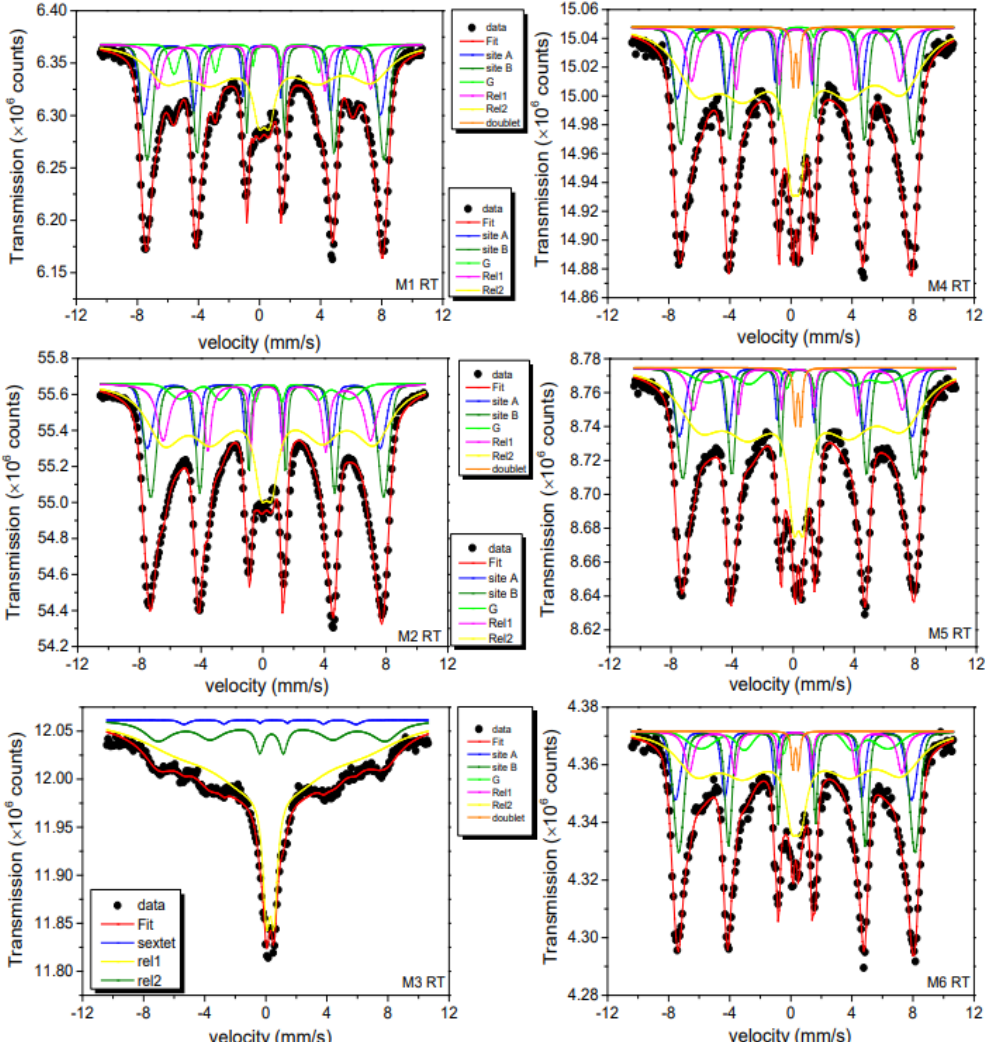
Figure 8. RT 57 Fe Mössbauer spectra for the M series. The subspectra discussed in the text are also shown in the figure. Bottom boxes are the components belonging to the corresponding left fit spectrum while top boxes belong to the right fit spectrum. G stands for α -FeOOH phase.